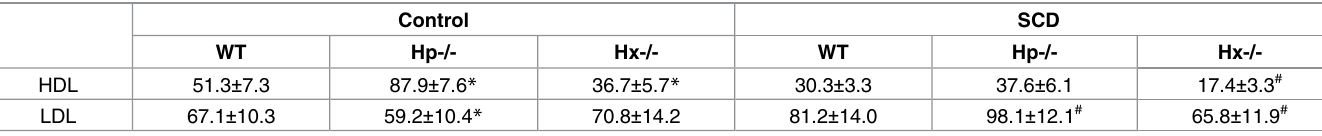
Table 4. Plasma lipoprotein levels (mg/dL) in wild-type (WT), Hp − / − and Hx − / − mice with and without sickle cell disease (SCD; n = 8 each group).